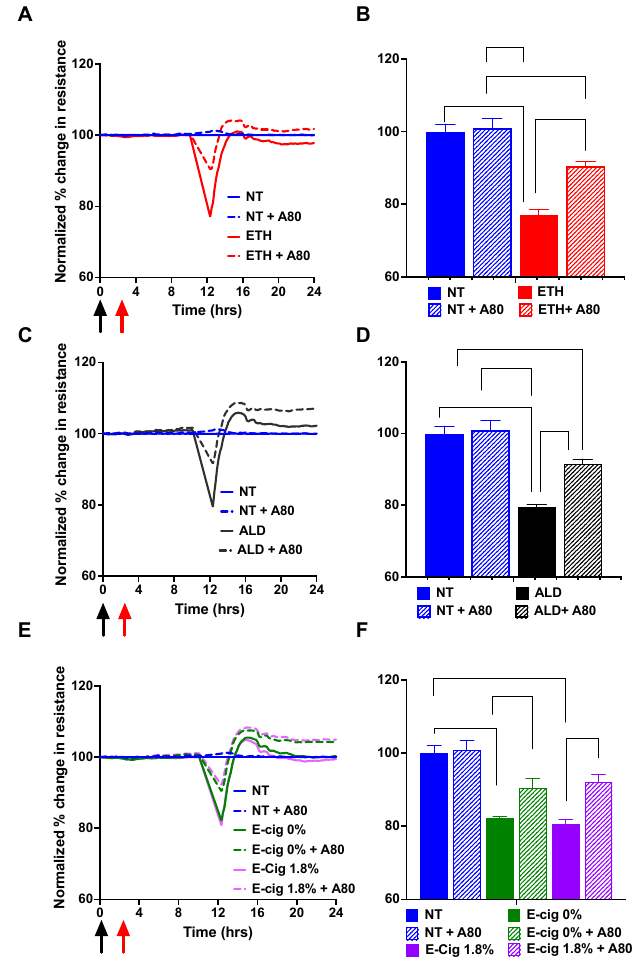
Figure 8. P2X7r inhibition protected barrier function. Trans-Endothelial Electrical Resistance (TEER) was measured continuously in hBMVECs with or without P2X7r inhibitor A804598 (at time 0 marked as black arrow) and exposed to ETH ( A , B ), ALD ( C , D ), or 1.8% e-Cig ( E , F ) (at 2 h marked as red arrow). After baseline TEER was achieved (between 6–7 days), the inhibitor and stimulators were added, and resistance was measured at 4000 Hz for the duration of the time shown. ( A , C , E ) are representative images from hBMVEC exposed to ETH, ALD, and 1.8% e-Cig respectively. ( B , D , F ) are average normalized percent change in TEER with positive SD ( n = 3–5). Significance values from a two-way ANOVA analysis is shown in the graphs.